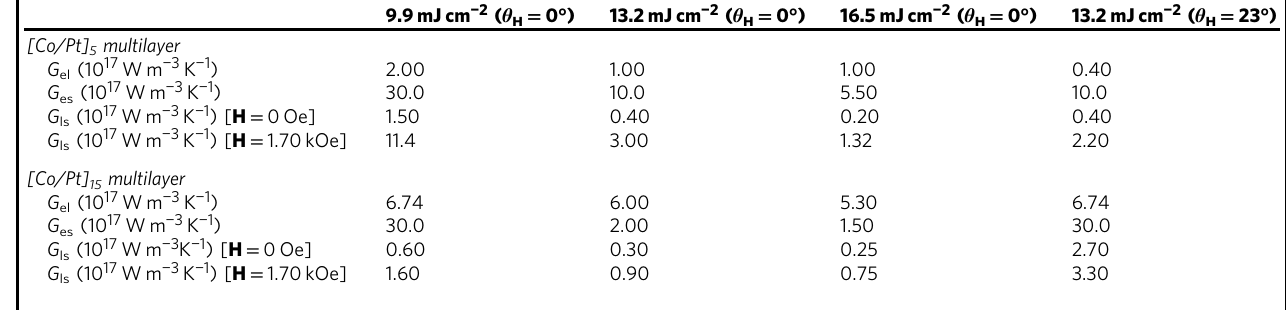
Table 1 List of fi tting parameters with variation of pump fl uences and external fi eld